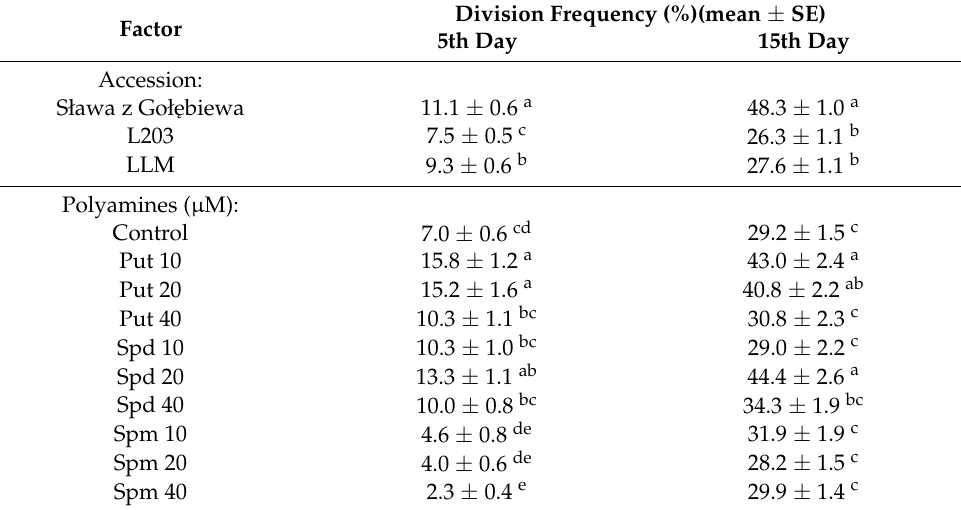
Table 2. Mean effect of accession and exogenous putrescine (Put), spermidine (Spd), and spermine (Spm) on the division frequency of protoplast-derived cells of Brassica oleracea L. var. capitata. The values are the means ± SE ( n = 60). The data in columns denoted with the same letter were not significantly different ( p ≤ 0.05,